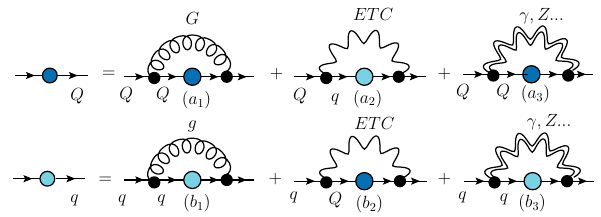
Fig. 1 TheSchwinger–Dysonequations[40]forQCD(q ≡ quark)and TC (Q ≡ technifermion) including ETC and electroweak or other cor- rections ( γ, Z ... ). In the above figure G ( g ) indicate technigluons (glu- ons)